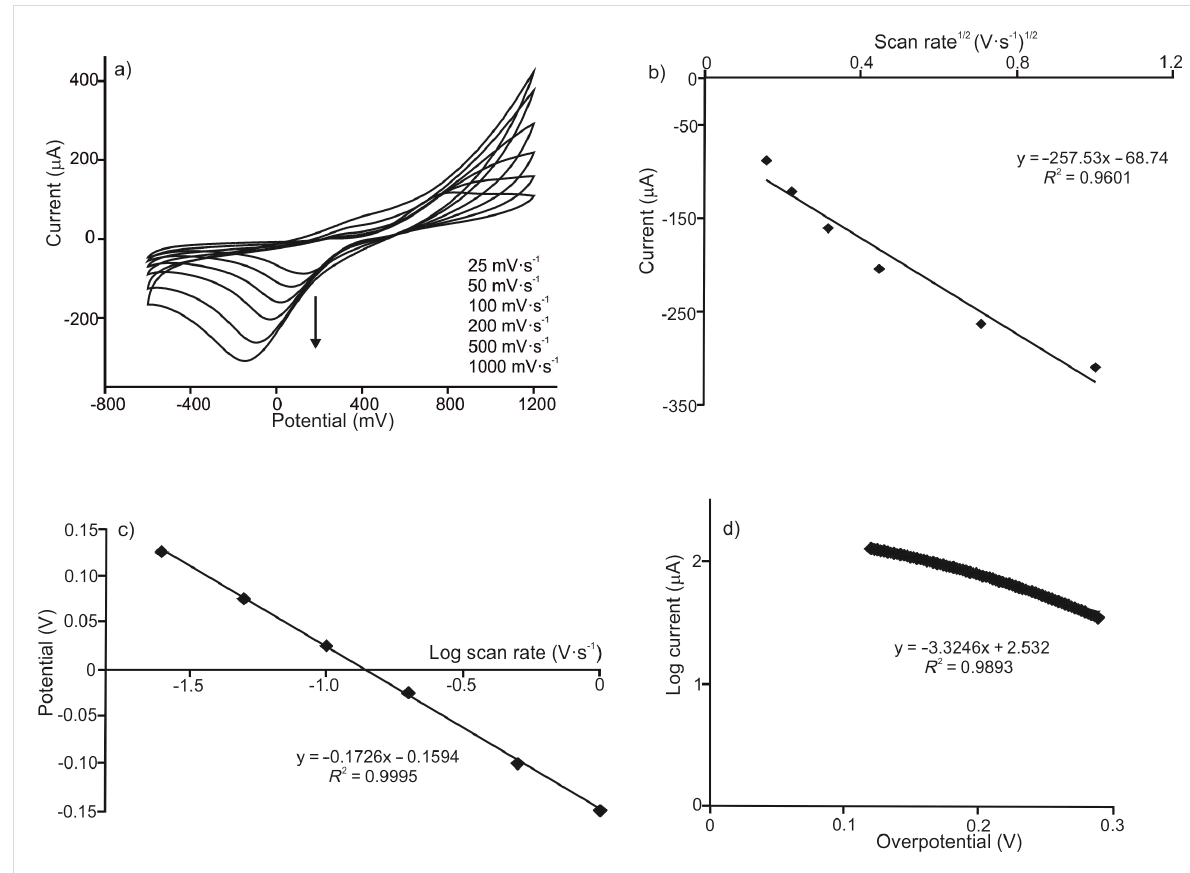
Figure 5: Effect of the scan rate in PEDOT/PSS/AuNP immersed in catechol 10 − 3 mol·L − 1 . (a) CVs collected at 0.025, 0.05, 0.1, 0.2, 0.5 and 1.0 V·s − 1 ; (b) linear relationship between I c and the square root of the scan rate; (c) linear relationship between E c and the log of the scan rate and (d) Tafel plot representing the logarithm of the intensity vs the